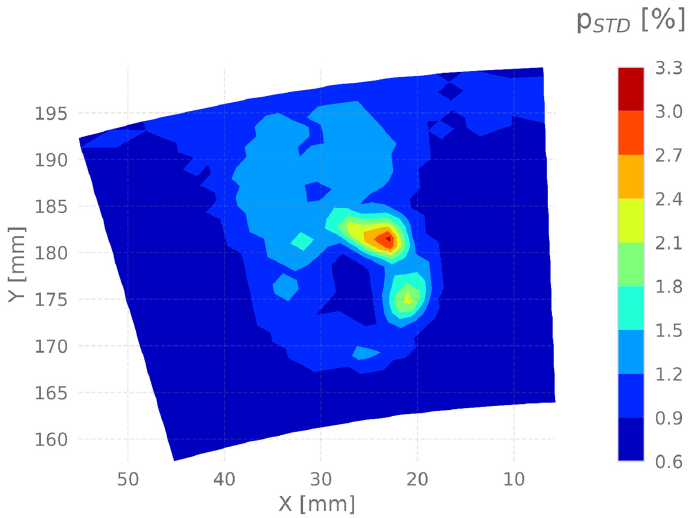
Figure 20. STD of total pressure upstream of the stator.